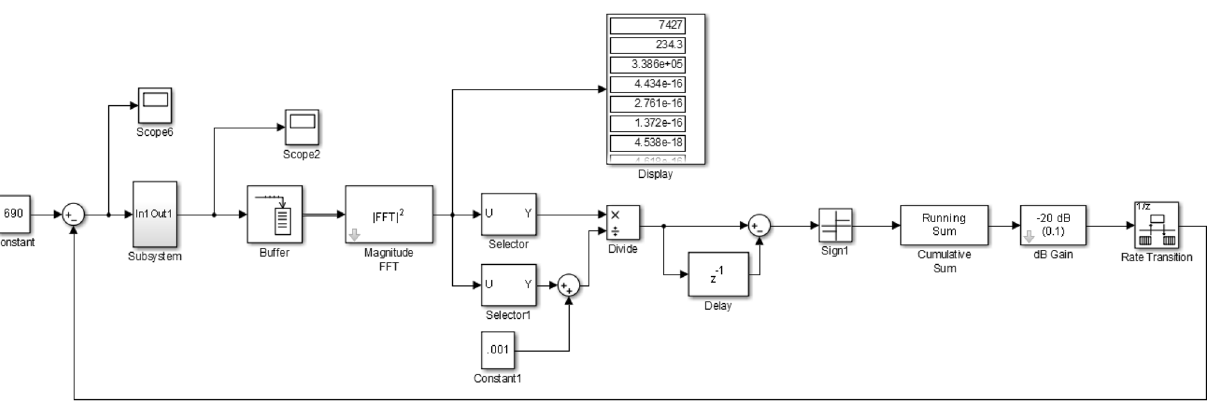
Fig. 7 Simulink - extreme control system model